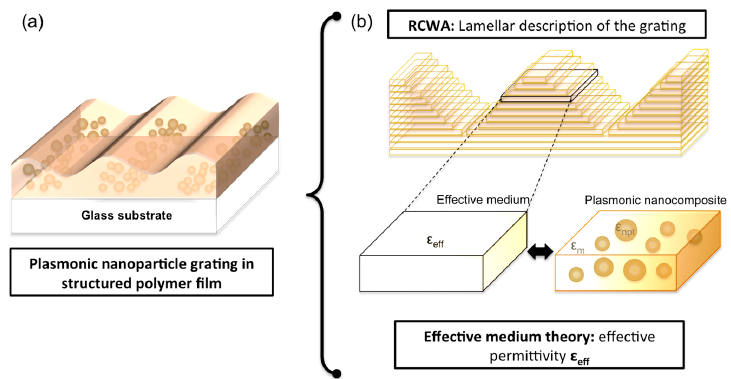
Figure 1. ( a ) Gold nanoparticle gratings in polymer thin films and ( b ) modeling of the system by combining the RCWA and the effective medium theory.